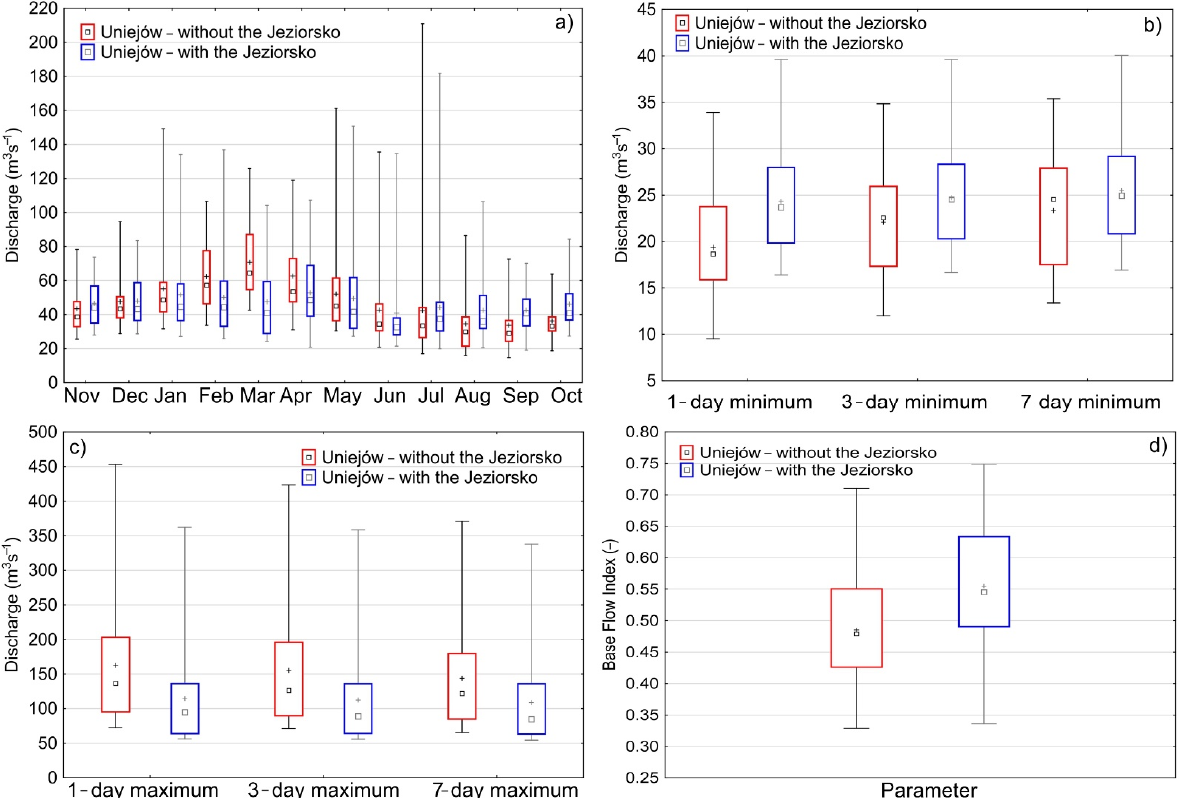
Figure 3. Effect of the Jeziorsko reservoir on monthly flows ( a ), minimum flows ( b ), maximum flows ( c ), and base flow index ( d ).